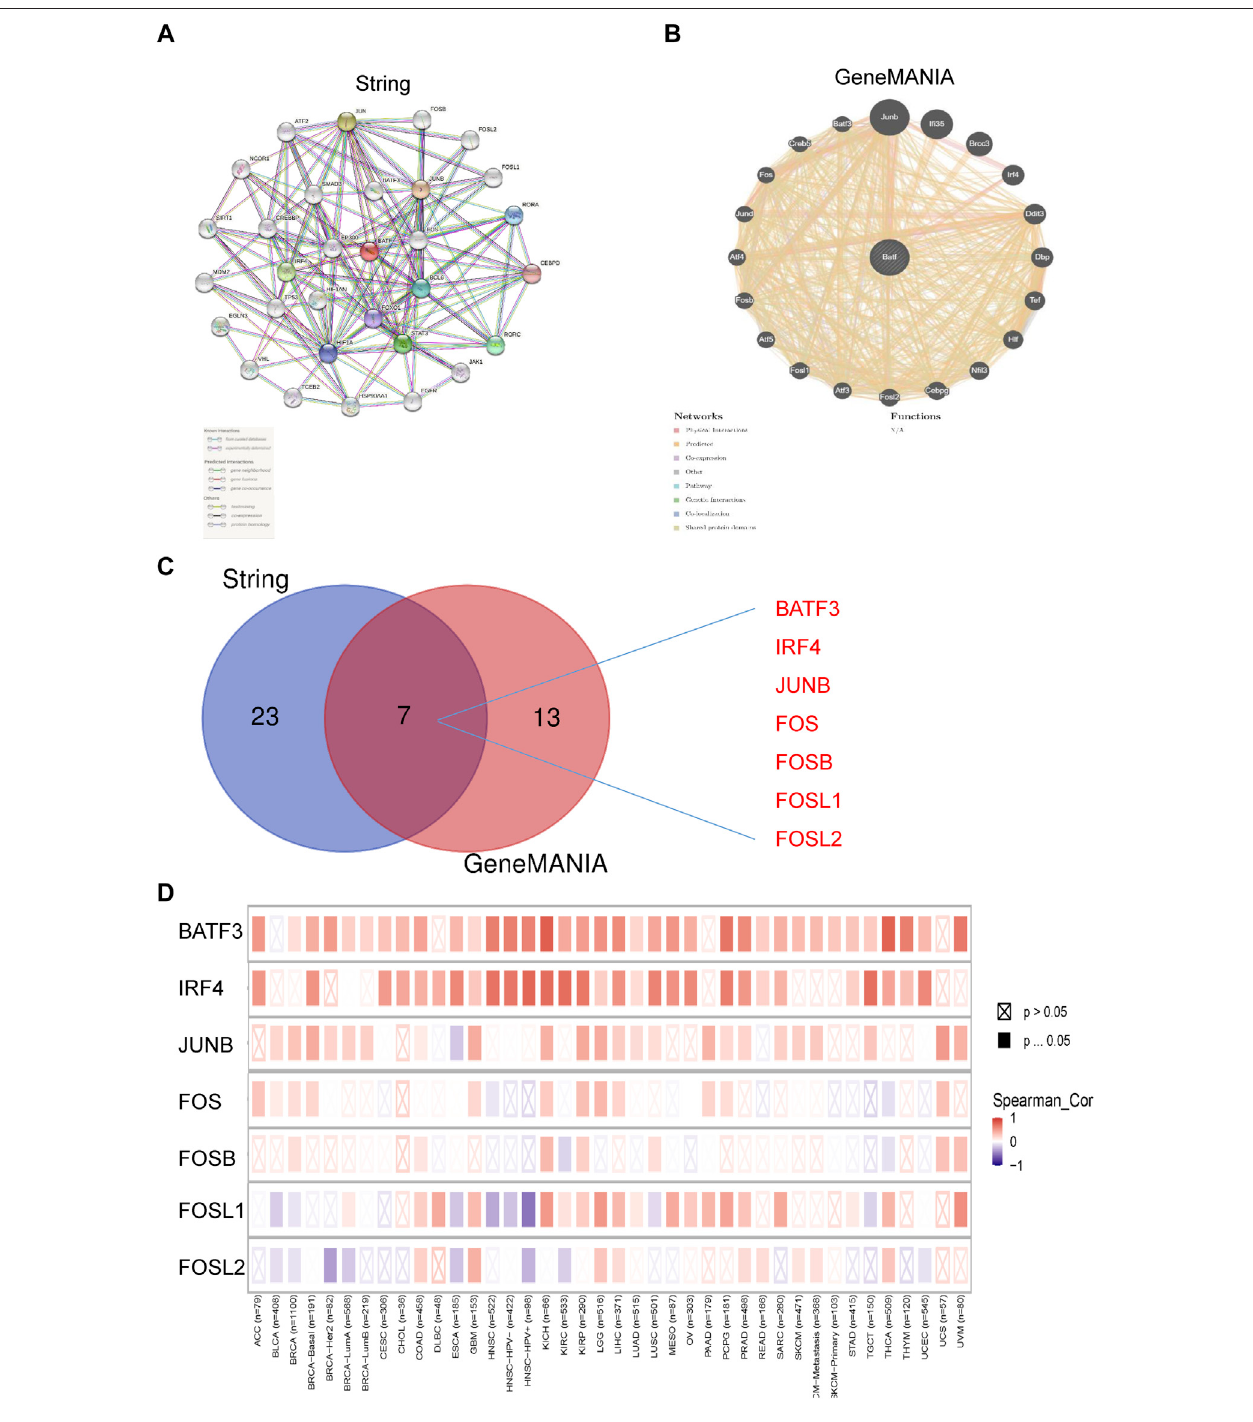
FIGURE 9 | PPI regulatory network of BATF. (A) PPI regulatory network of BATF derived from String tool. (B) PPI regulatory network of BATF derived from GeneMANIA tool. (C) An intersection analysis of BATF-related genes between String derived PPI and GeneMANIA derived PPI network. (D) Correlation between BATF and BATF-related gene